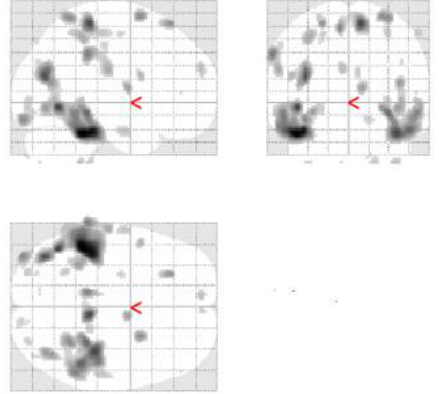
Figure 3. Semiquantitative analysis with SPM 12 of the first FDG-PET, showing bilateral temporo- parietal hypometabolism.